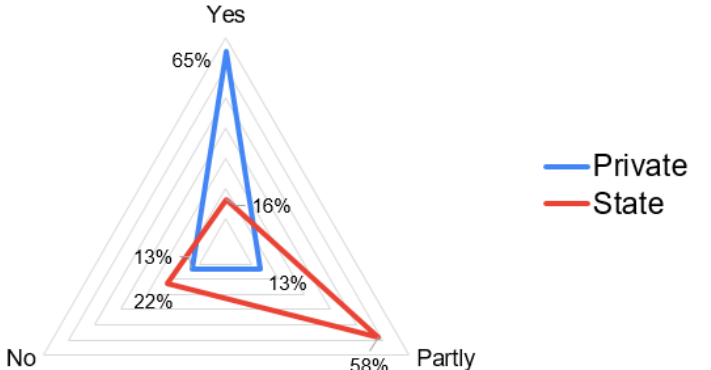
Figure 3: Percentage of respondents who indicated that STEM (private and public schools) is implemented in their